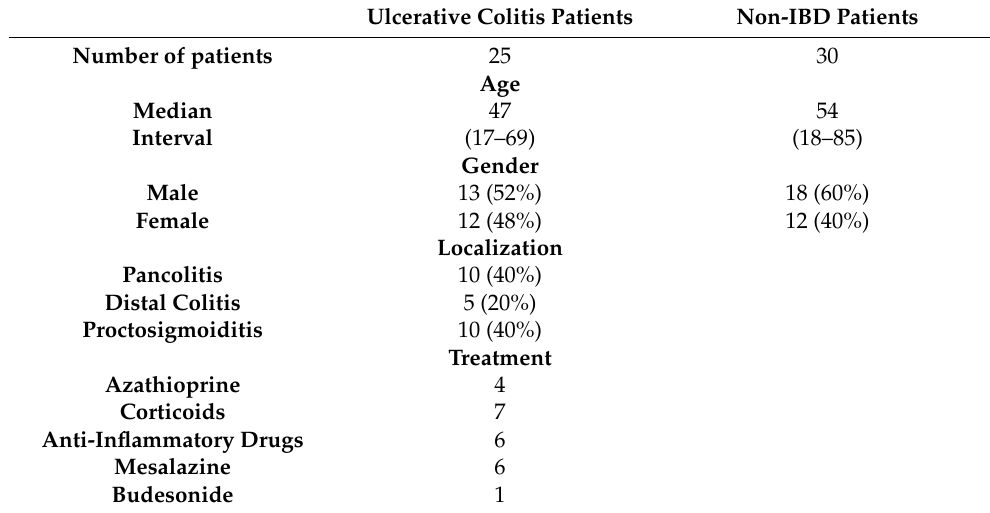
Table 1. Information about UC and Non-IBD